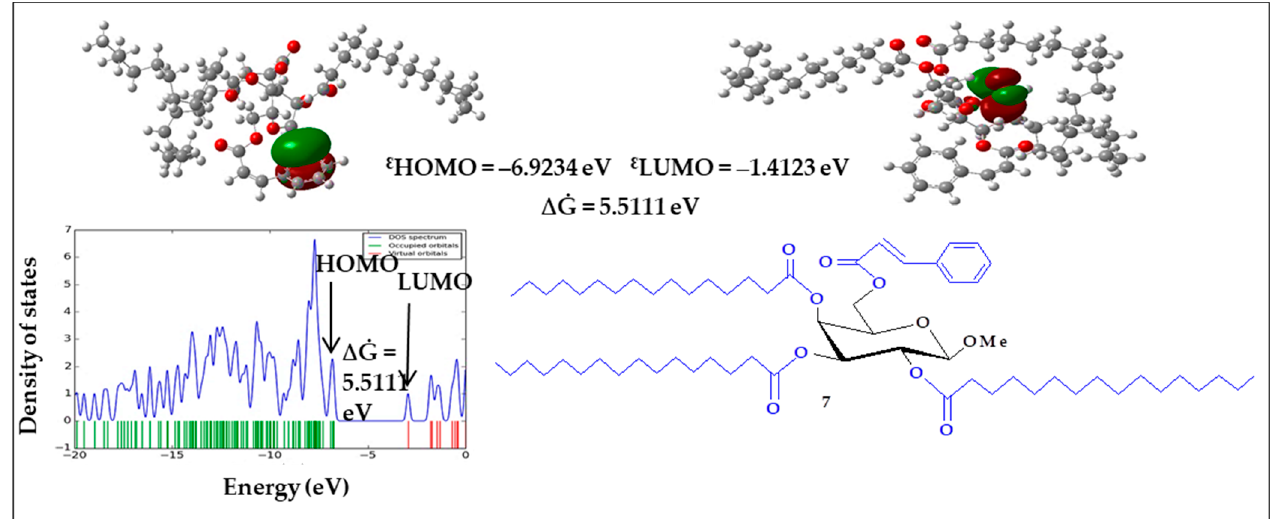
Figure 4. Molecular orbital distribution plots of HOMO-LUMO, including the density of MGP analog (7) states at DFT/B3LYP/3-21G.